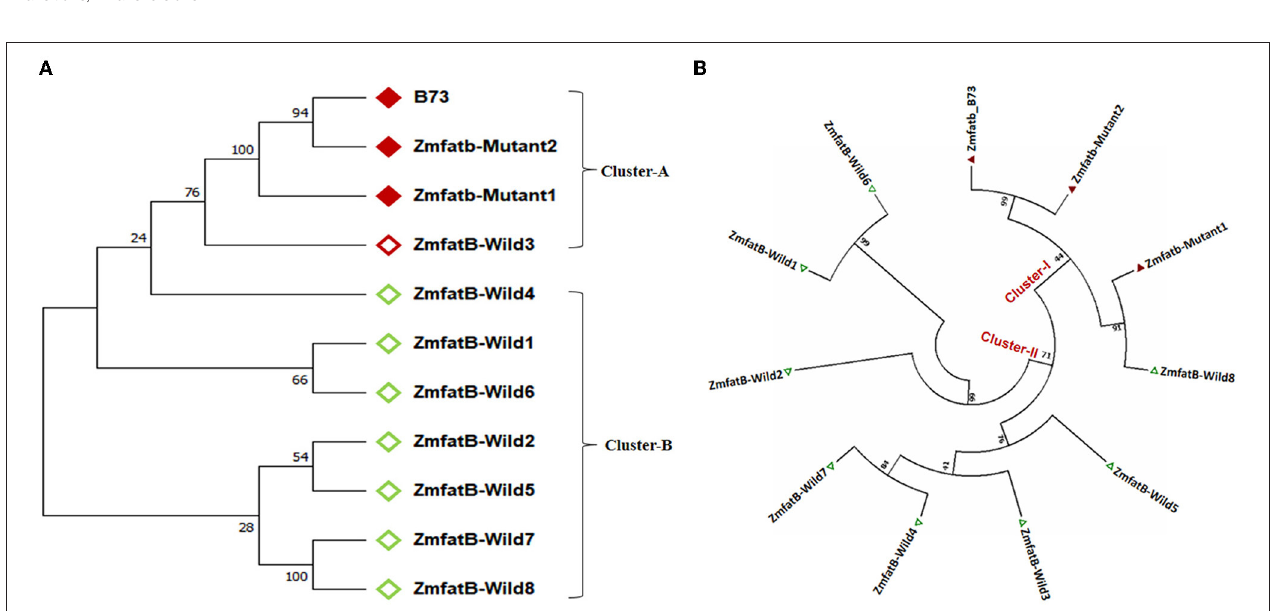
FIGURE 2 | (A) Nucleotide based phylogenetic tree among the sequenced maize genotypes with 10000 bootstra p-value. (B) Protein-based phylogenetic tree among the sequenced maize genotypes with 10000 bootstra p-value.